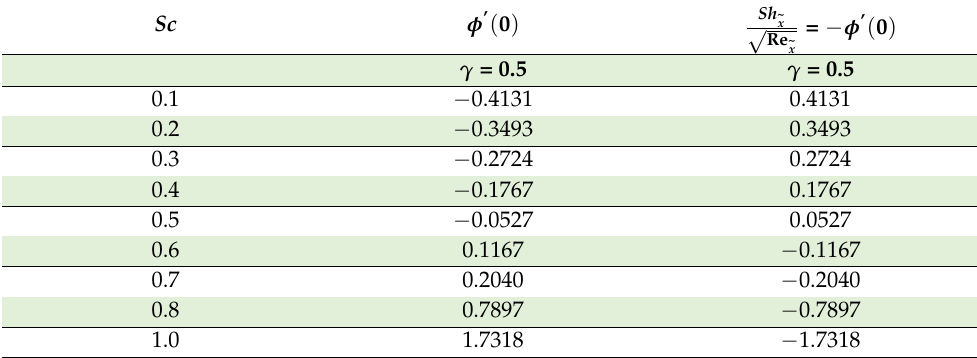
Table 9. Effect of Sc on Sherwood number for cylinder.